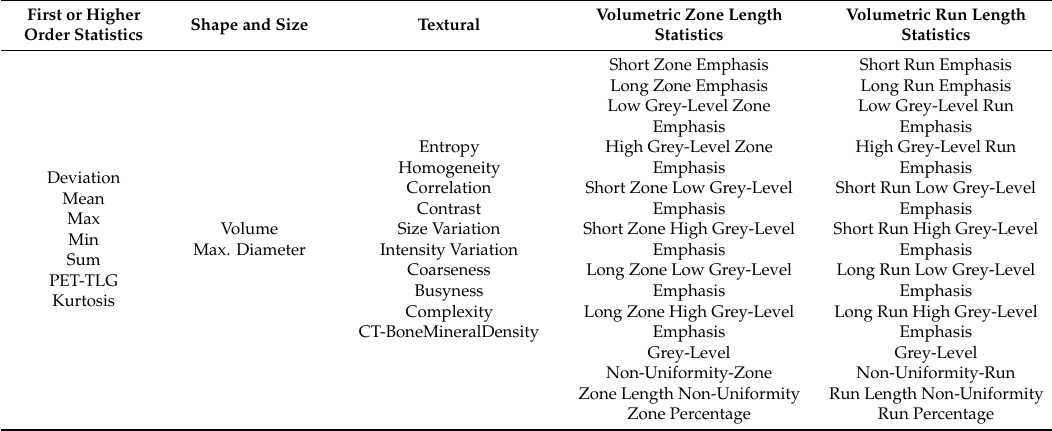
Figure 1. Example of Region of interest (RoI) definition for a bone PET/CT hotspot in InterView FUSION Software. The 2D slice includes the defused PET uptake (kidneys and bone metastasis in dark blue, green, yellow, and red) co-registered with the CT image (in grayscale). The blue contour around the metastatic uptake is defined and named (Bone 11) by the NM expert. Table 1. List of the calculated features: PET-based and CT-based features. Note that the total lesion glycolysis (TLG) is PET-specific and BoneMineralDensity is CT-specific.